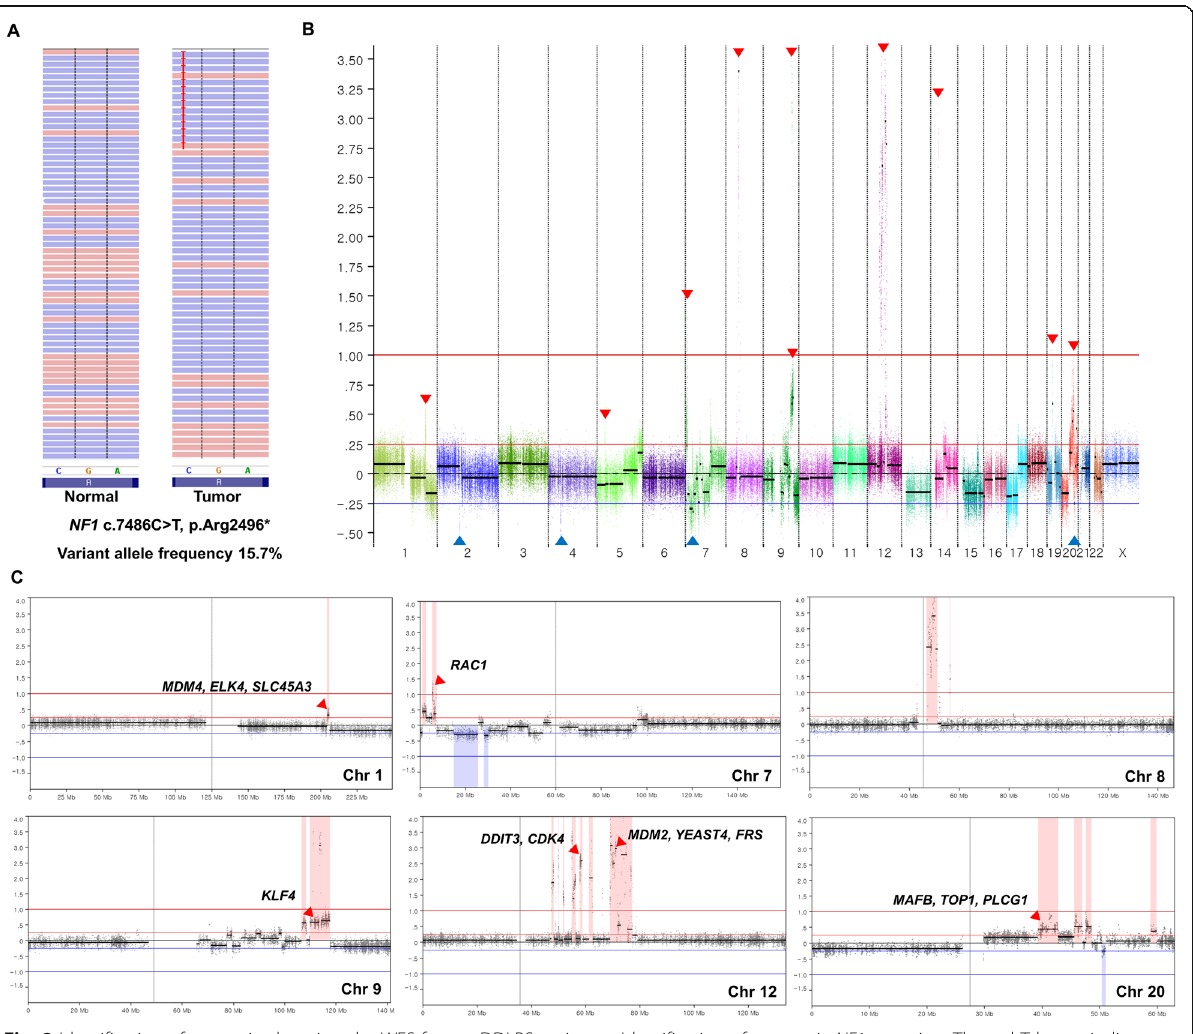
Fig. 2 Identification of genomic alterations by WES from a DDLPS patient. a Identification of a somatic NF1 mutation. The red T letters indicate the presence of a truncating mutation (c.7486C > T, p.Arg2496*, variant allele frequency 15.7%) in NF1 gene. b Genome-wide copy number alternation profile of the DDLPS patient. X-axis represents individual chromosome, and Y-axis represents depth ratio (tumor/constitutional) in log2 scale. Red and blue lines indicate the threshold of copy gain and copy loss. Bold red line indicates the threshold of amplification. Red and blue arrows represent the copy gain/amplification and loss, respectively. c Copy number alternation profiles of chromosome 1, 7, 8, 9, 12, and 20. X- axis represents individual chromosome, and Y-axis represents depth ratio (tumor/constitutional) in log2 scale. Red arrows represent the copy gain or amplification regions where known DDLPS related genes are located. Chromothripsis events were observed in 7p, 9q, and